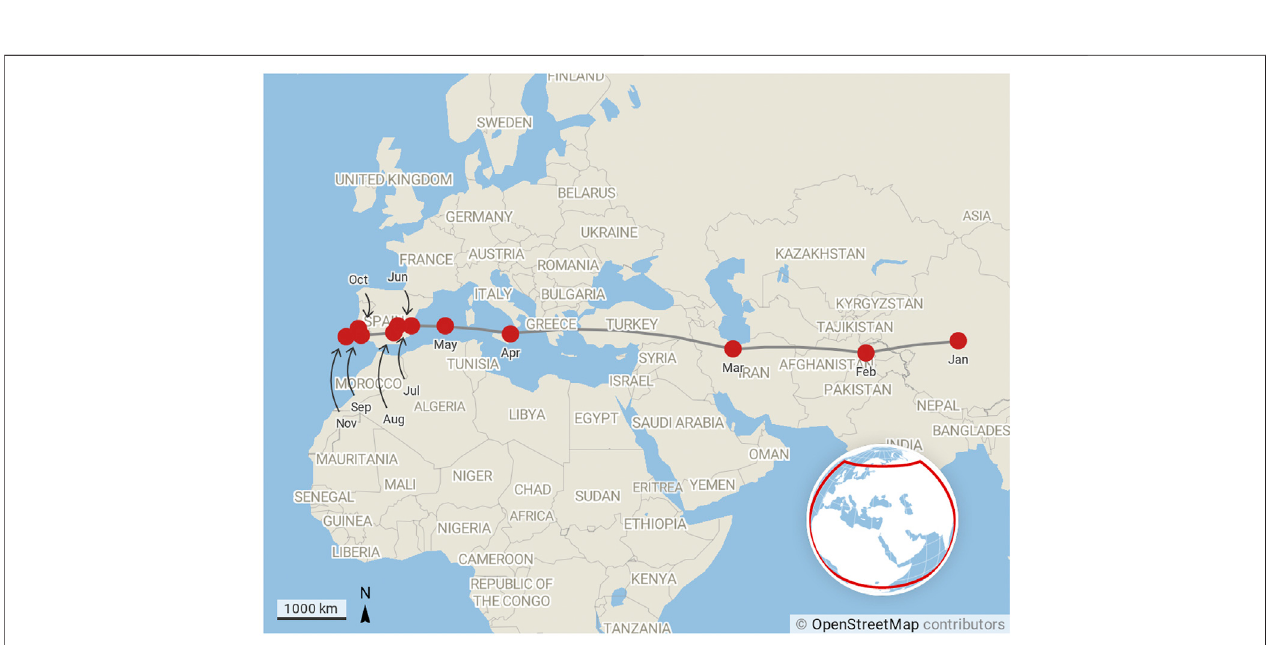
FIGURE4 | Motion of thecentreof mass ofresearch production month bymonth for COVID-19 publications from January 2020 toNovember2020.The centre of mass calculation is weighted by citations as described by Eq. 4 .